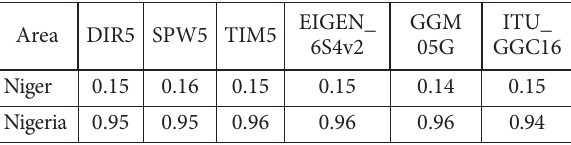
Table 5. RMS of geoid height differences for pure satellite GGMs in metres at d/o 200 after SEM EIGEN_ GGM ITU_ Area DIR5 SPW5 TIM5 6S4v2 05G GGC16 Niger 0.15 0.16 0.15 0.15 0.14 0.15 Nigeria 0.95 0.95 0.96 0.96 0.96